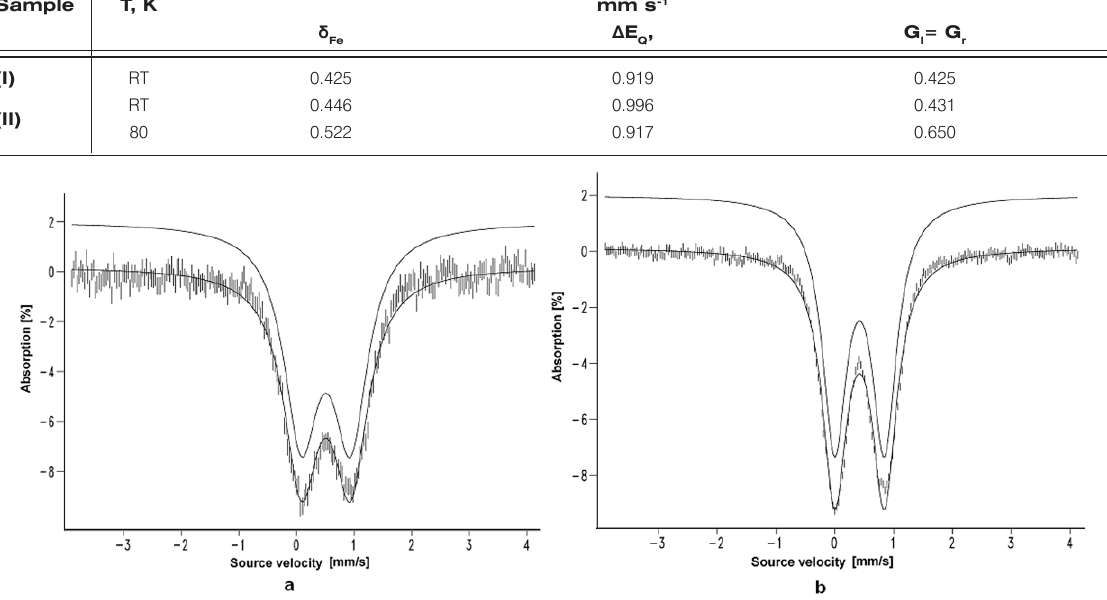
Figure 4. The Mossbauer spectra of II at: a - 80 K and b - 300 K.